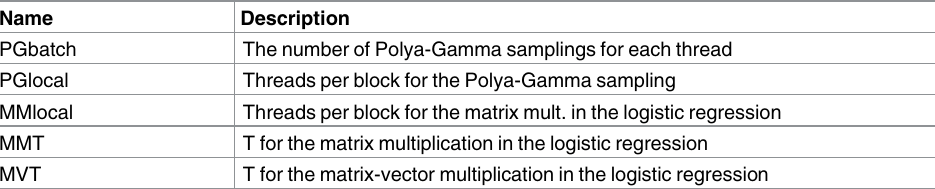
Table 1. Implementation parametersfor the multinomial logistic regression.